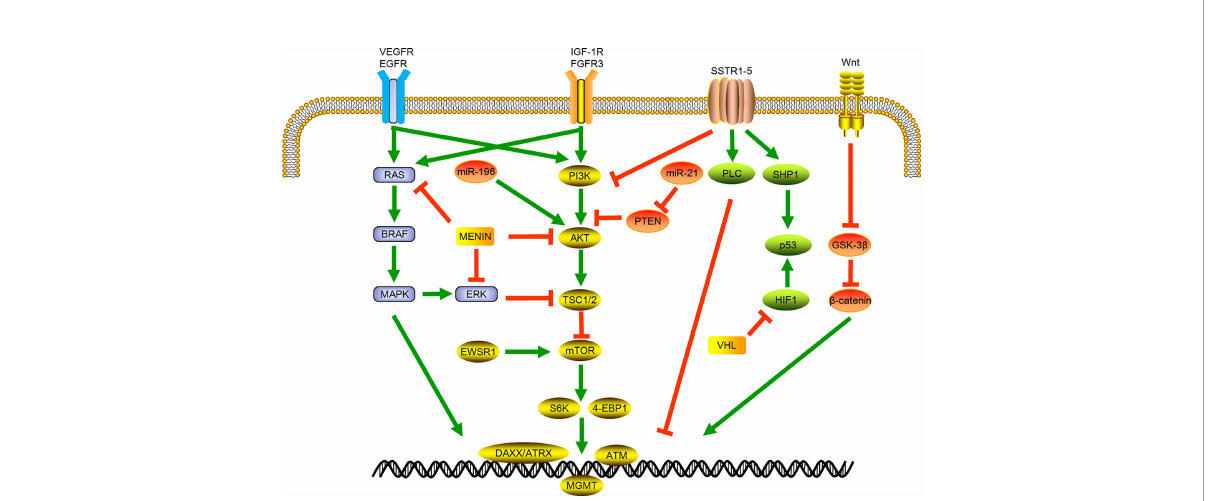
FIGURE 1 Schematic of signaling pathways involved in pancreatic neuroendocrine tumor development and progression. VEGFR, vascular endothelial growth factor receptor; EGFR, epidermal growth factor receptor; BRAF, B-Raf Proto-oncogene; MAPK, mitogen-activated protein kinase; miR, micro RNA; ERK, Extracellular-signal-regulated kinase; EWSR1, EWS RNA binding protein 1; IGF-1R, insulin-like growth factor receptor 1; FGFR3, fi broblast growth factor receptor 3; PI3K, phosphatidylinositol-3-kinase; AKT, protein kinase B; TSC1/2, Tuberous sclerosis 1; mTOR, mammalian target of rapamycin; S6K,; 4-EBP1, Eukaryotic translation initiation factor 4E-binding protein 1; DAXX, death domain-associated protein; ATRX, X-linked mental retardation and a-thalassemia syndrome protein; ATM, ataxia telangiectasia; SSTR, somatostatin receptor; PTEN, phosphatase and tensin homolog deleted; PLC, phospholipase C; SHP1, Src homology region 2 domain-containing phosphatase-1; HIF1, hypoxia-inducible factor 1; VHL, Von